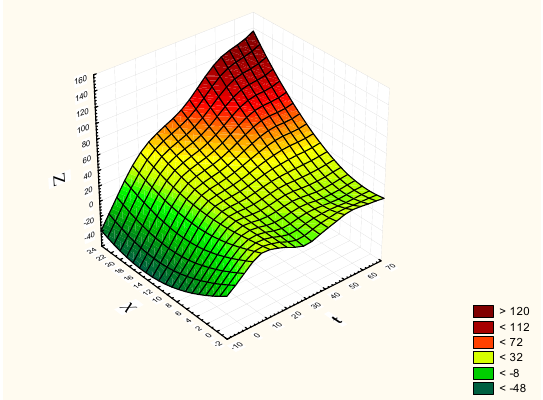
Figure 10. Graph of polynomial smoothing of the dependence of OXZt.